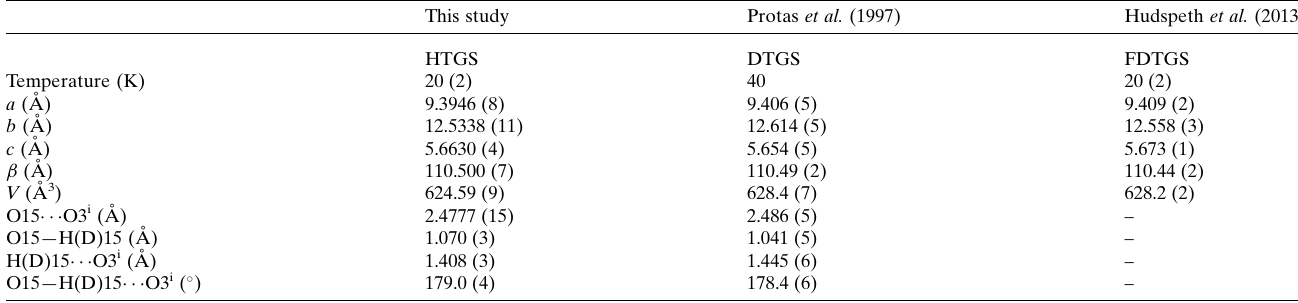
Table 1 Lattice constants, interatomic distances and angles for HTGS, DTGS, and FDTGS at low temperatures.